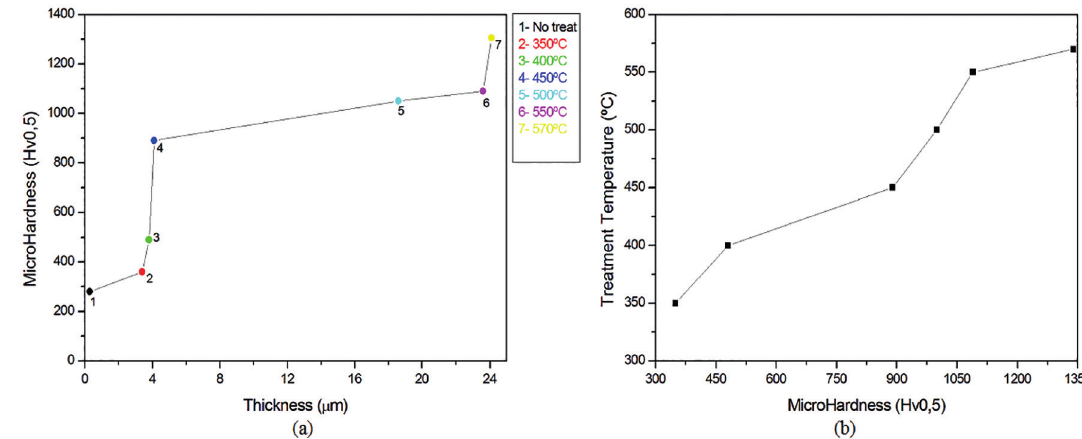
Figure 7: Microhardness as a function of (A) the layer thickness and (B) the treatment